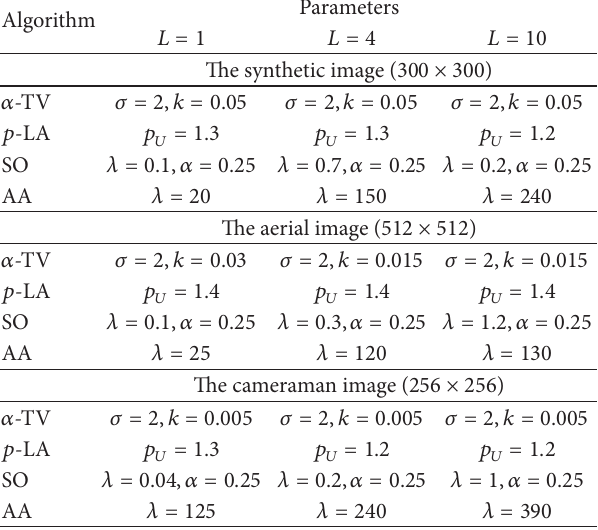
Table 1: Parameters used in the comparison study.